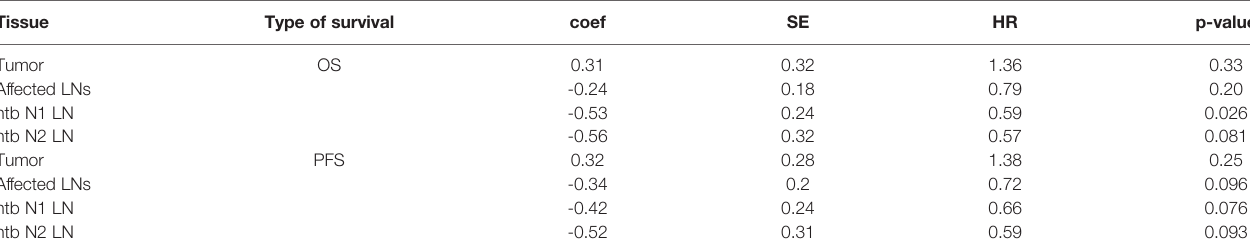
TABLE 2 | Results of univariate Cox regression of the TIDE score in tumor, affected LNs, N1 ntbLNs and N2 ntbLNs. Tissue